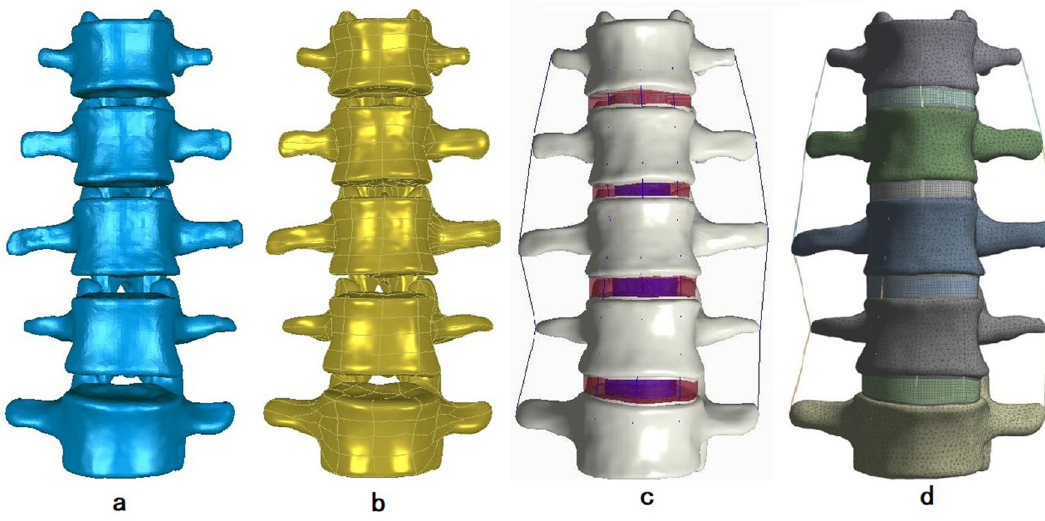
Figure 6. FE models: ( a ) three-dimensional model of the L1 ~ L5 vertebrae, ( b ) the three-dimensional model processed by Geomagic Studio 12.0, ( c ) the three-dimensional model generated by Pro/Engineer5.0, and ( d ) the assembled three-dimensional model for FE